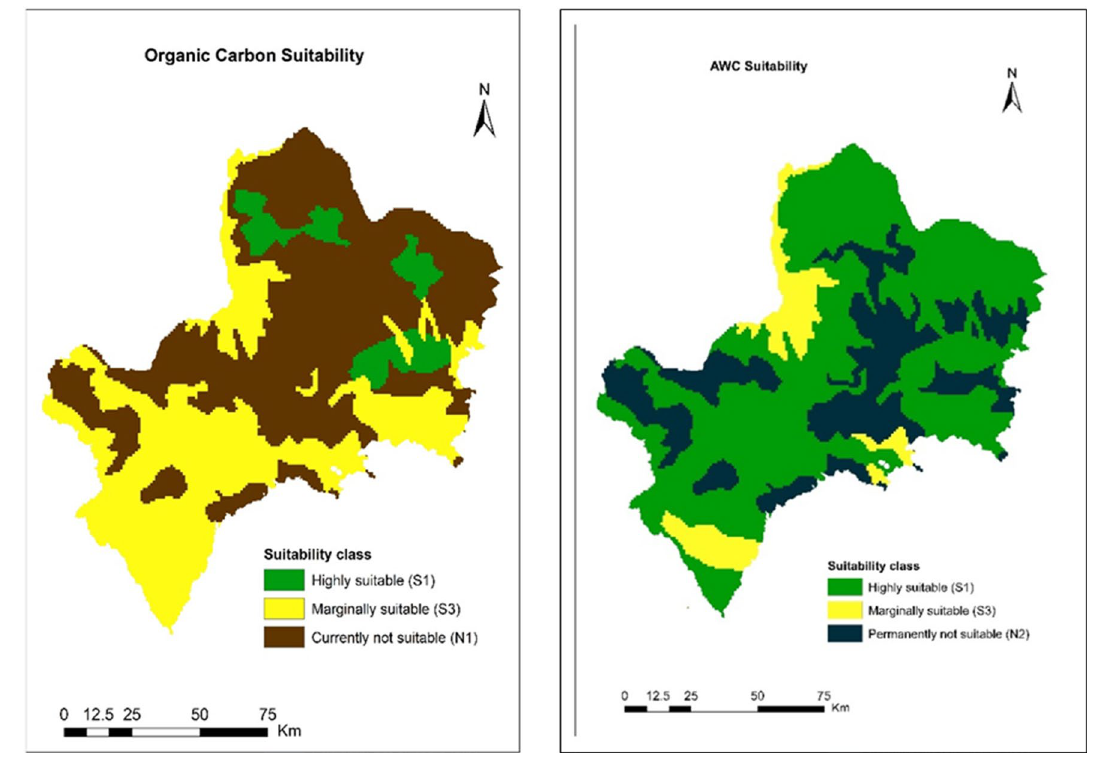
Fig. 5 Organic carbon and AWC suitability